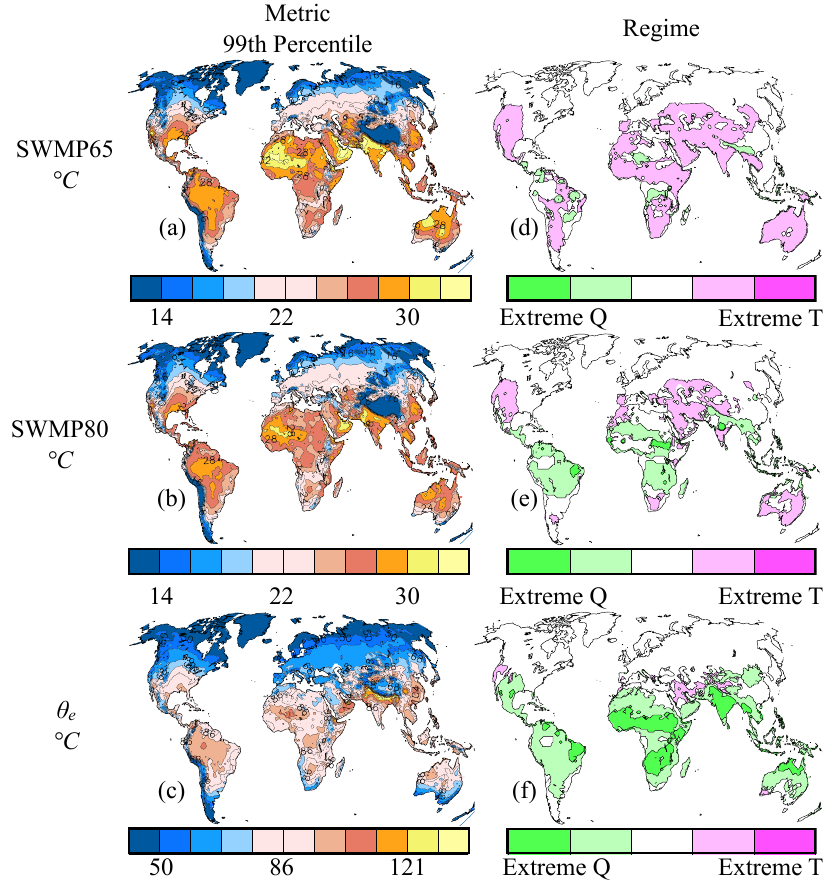
Figure 6. 99th percentile exceedance value of three metrics for (a) SWMP65, (b) SWMP80, and (c) θ E (left). Expected rank value T − Q regime maps (d) , (e) , and (f) (right) conditioned by (a) , (b) and (c) , respectively. Rank values for (d) – (f) are described in Fig.